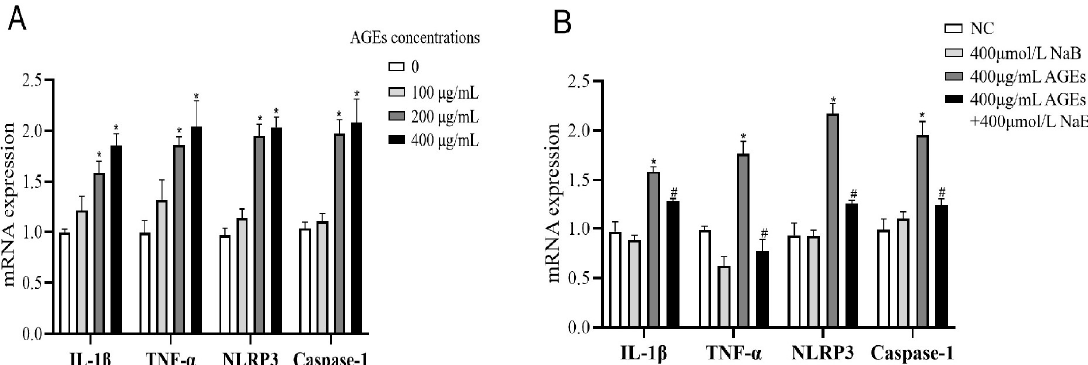
Figure 1. The mRNA expression of inflammatory cytokines of THP-1 cells ( n = 3/group). ( A ): THP-1 cells were treated with three different concentrations of AGE. ( B ): THP-1 cell were pre-treated with 400 µ mol/L of NaB for 24 h, and then treated with 400 µ g/mL of AGEs to induce inflammation. NC: normal control; L-AGEs: 100 µ g/mL AGEs; M-AGEs: 200 µ g/mL AGEs; H-AGEs: 400 µ g/mL AGEs; NaB: 400 µ mol/L NaB; AGEs: 400 µ g/mL AGEs; AGEs+NaB: pre-treated with 400 µ mol/L of NaB for 24 h, and then treated with 400 µ g/mL of AGEs. *: compared with the NC group, p < 0.05; #: compared with the AGEs group, p < 0.05.